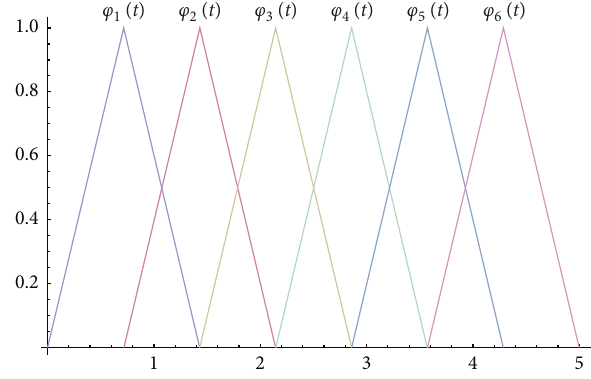
Figure 1: Galerkin hats for n � 7 and T �